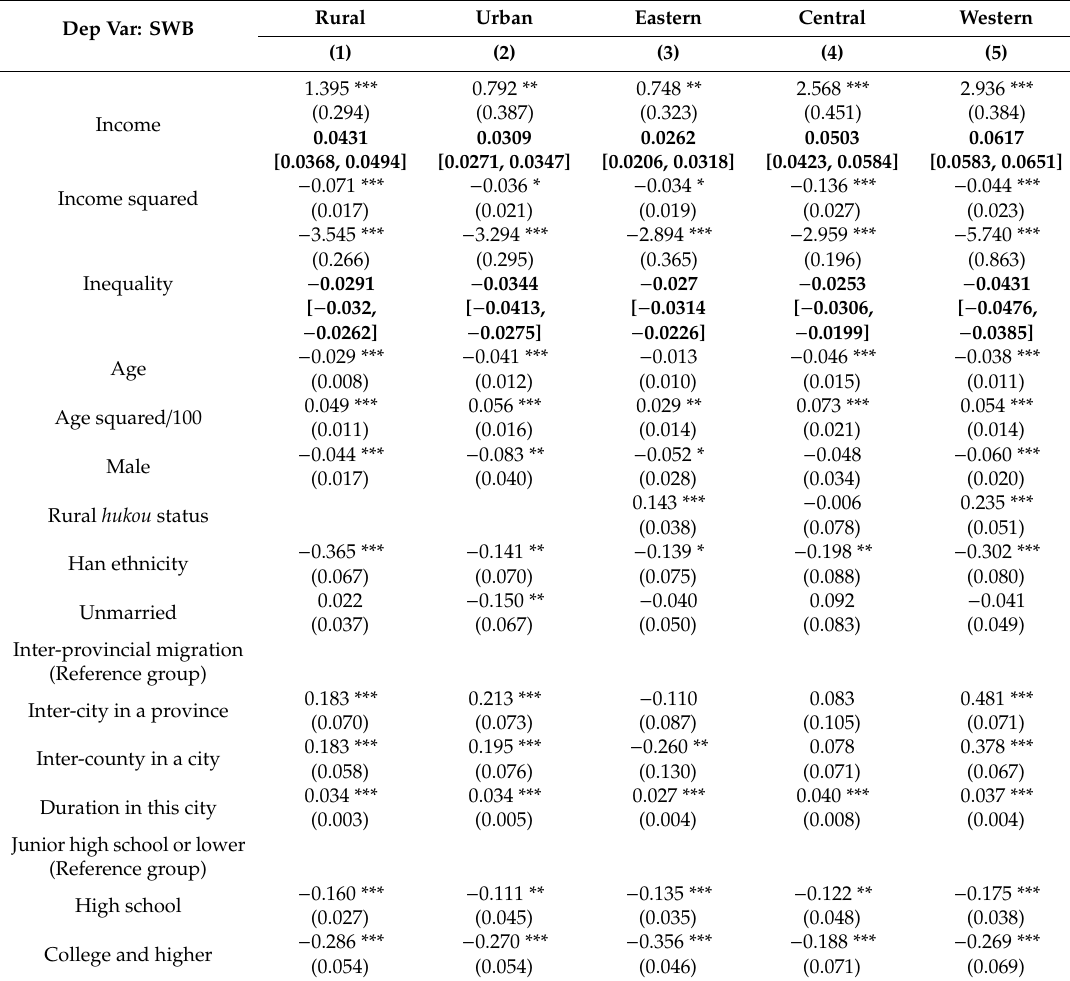
Table 4. Heterogeneous e ff ects by household registration status and